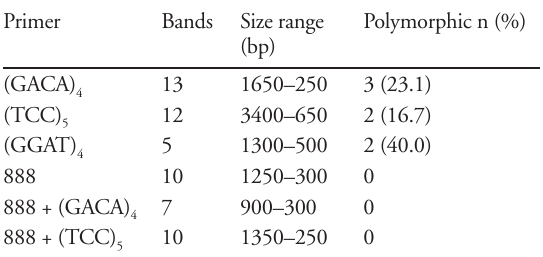
Table 3. Total number of detected bands, band size range and percentage (%) of polymorphic bands obtained in the six ana- lysed populations of E. andevalensis .